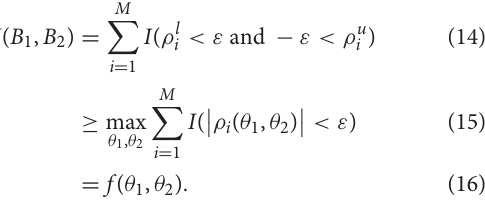
Frontiers in Neurorobotics |